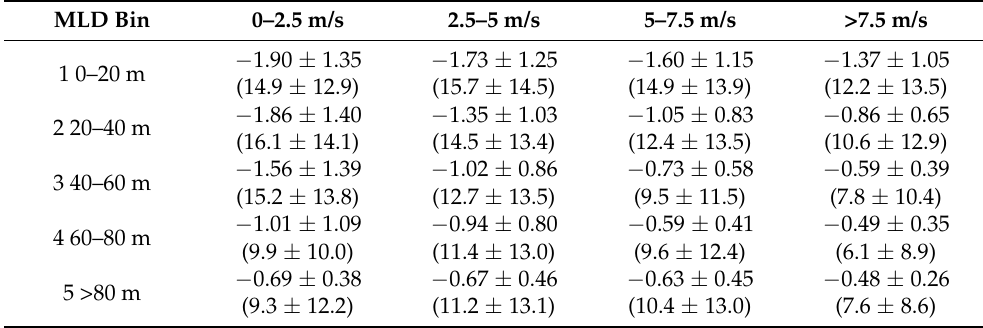
Table 4. The average and standard deviation of maximum cooling ( ◦ C) and recovery time (the number in brackets, unit: day) for different MLD bins for different TC translation